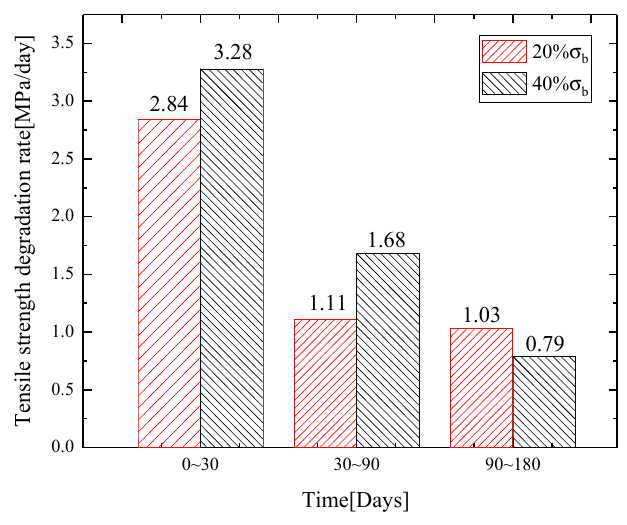
Figure 5. Strength degradation rate of GFRP bars.